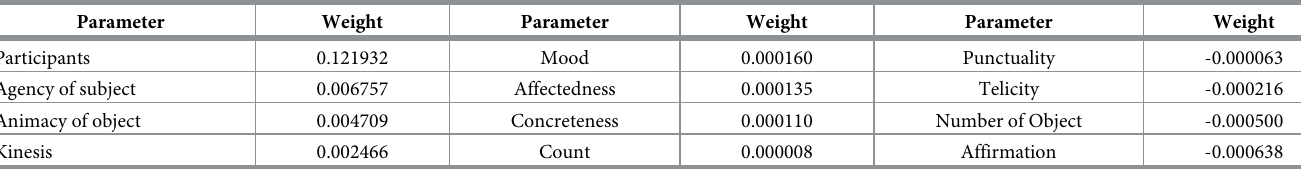
Table 5. Average weights for each Transitivity